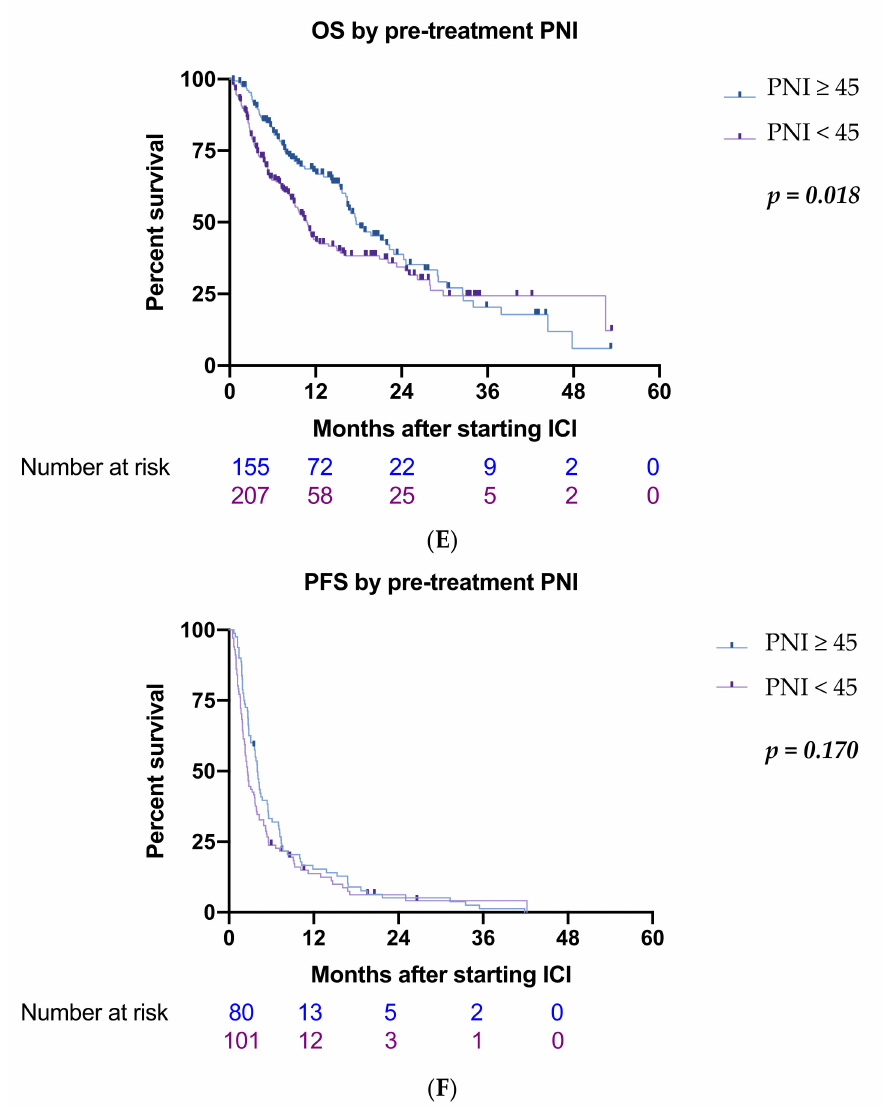
Figure 2. Kaplan-Meier curves for progression free survival (PFS) and overall survival (OS) according to inflammatory markers. ( A ) OS according to neutrophil to lymphocytes ratio (NLR), ( B ) PFS according to NLR, ( C ) OS according to platelet to lymphocytes ratio (PLR), ( D ) PFS according to PLR, ( E ) OS according to prognostic nutritional index (PNI), ( F ) PFS according to